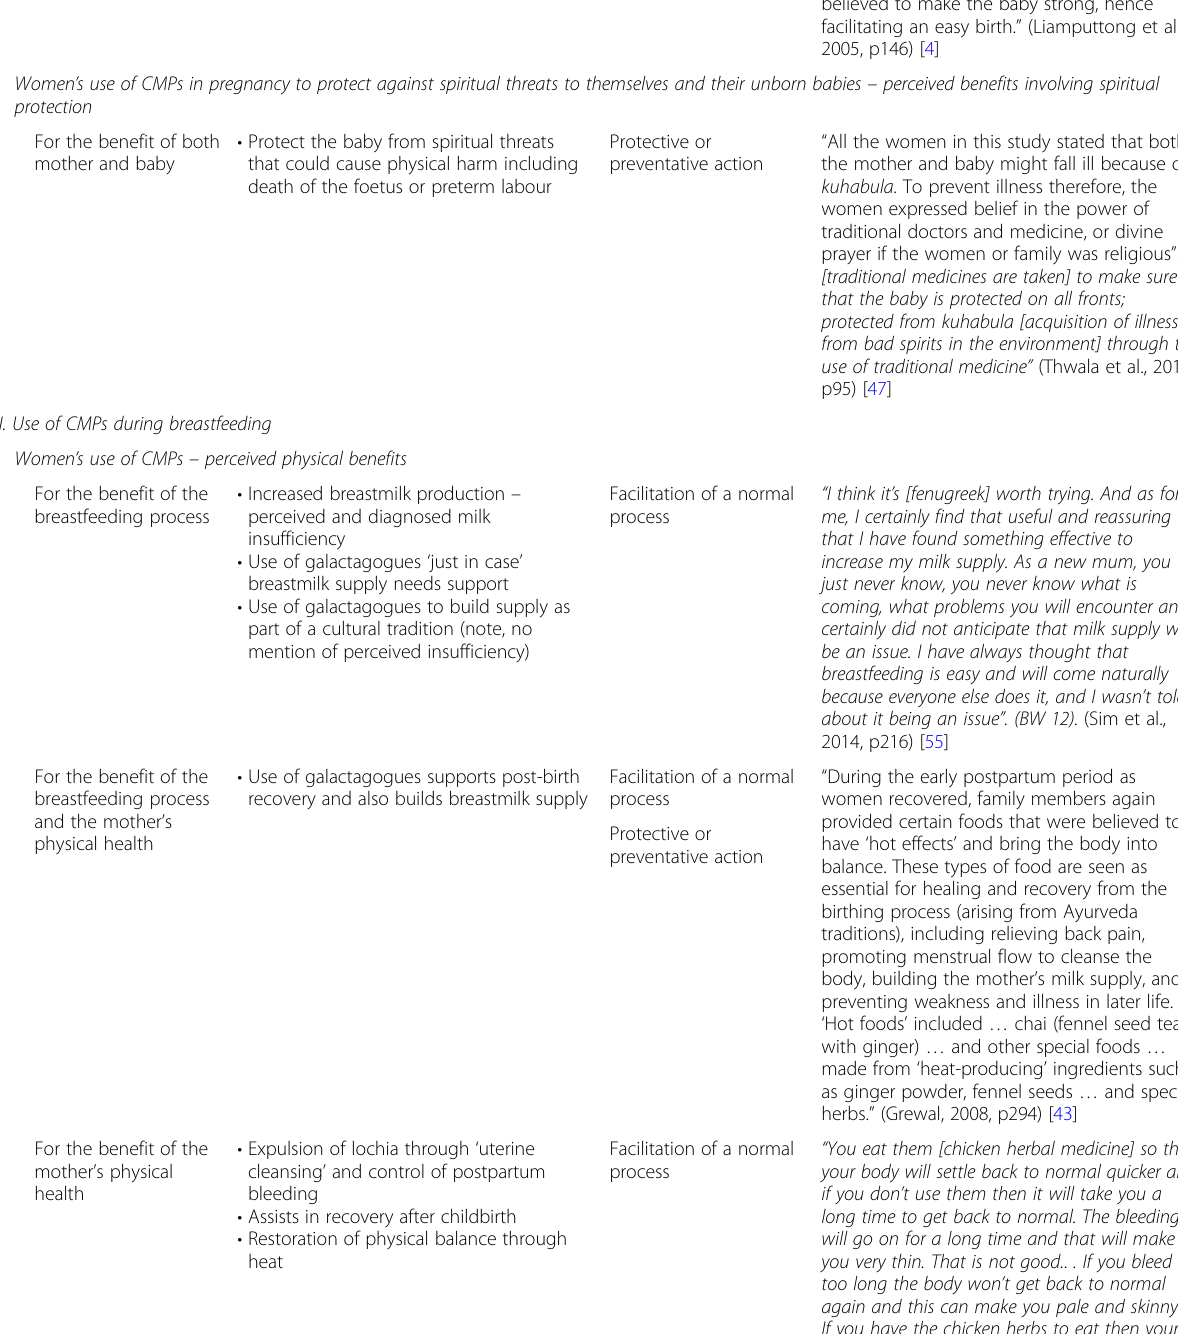
(Rutakumwa & Krogman, 2007)